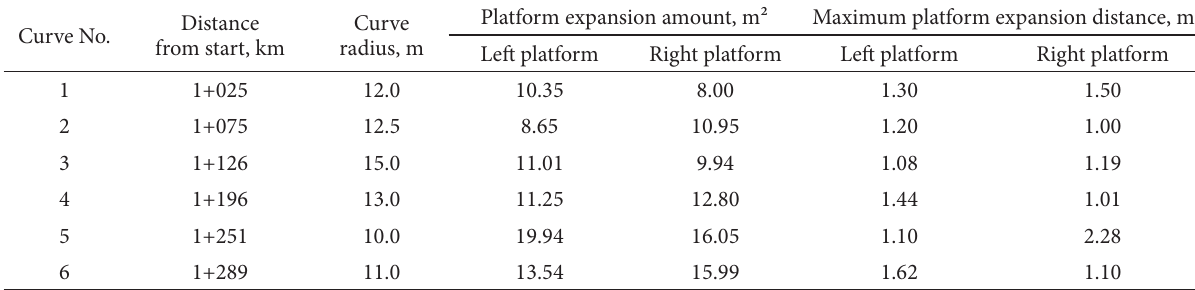
Table 5. Amounts of expansion required in curves for bus as a result of driving analysis Curve No.